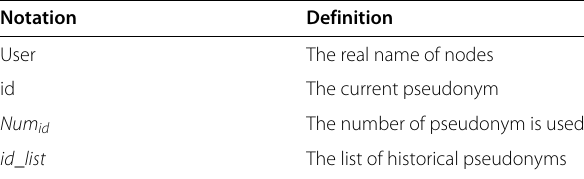
Table 1 The data definition stored in